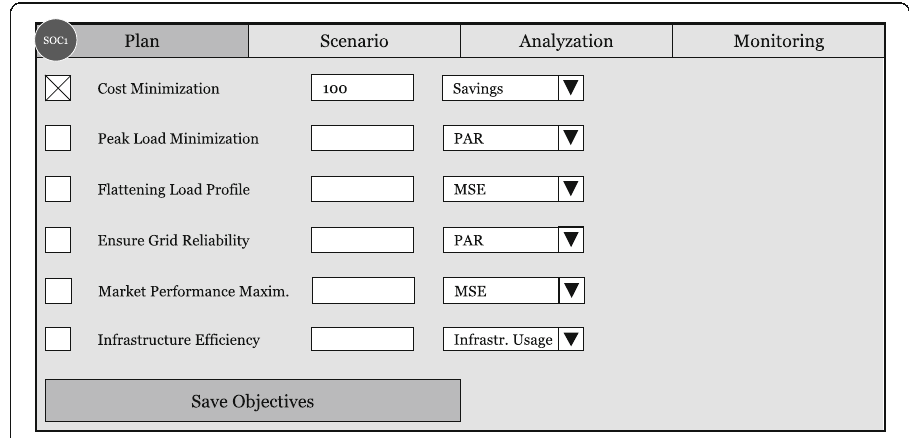
Fig. 7 Defining the objectives (schematic drawing)